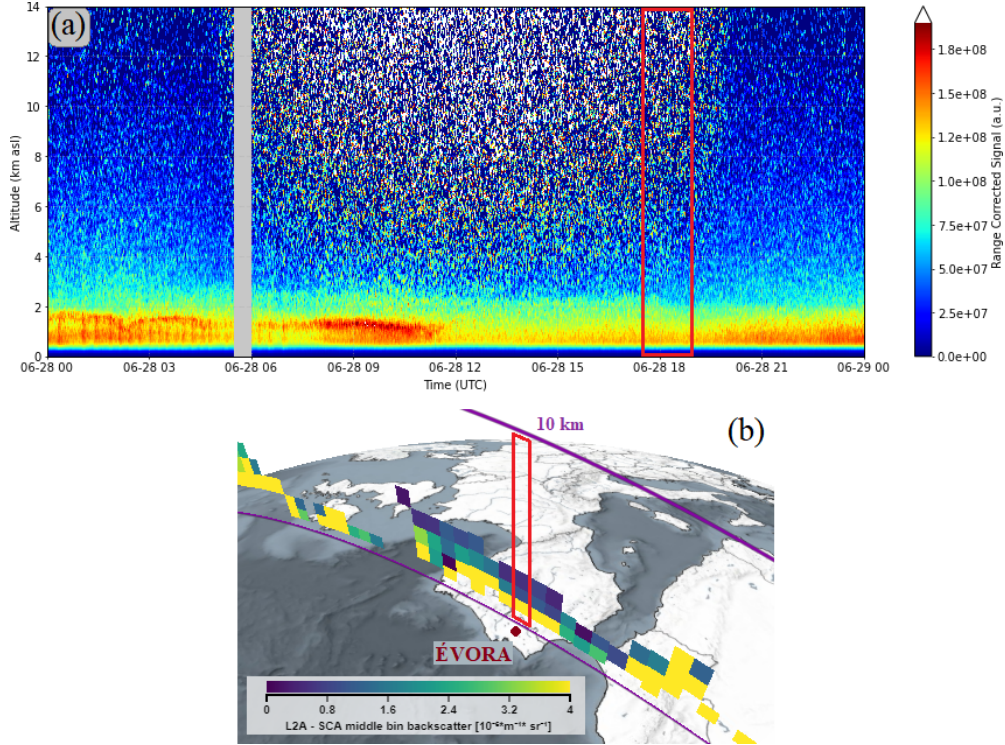
Figure 6. (a) Lidar range-corrected signal measured with the 355nm channel in Évora on 28 June 2019. (b) Aeolus SCAmb backscatter retrievals along the considered orbit (4913) with the profile closest to the station marked in red (source: VirES for Aeolus, https://aeolus. services/, last access: 7 January 2022). Quality flags are